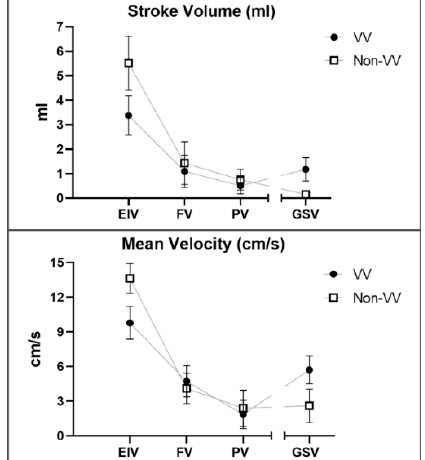
Figure 3. TRANCE-MRI hemodynamic parameters, consisting of stroke volume, forward flow volume, backward flow volume, regurgitant fraction, absolute volume, mean flux, stroke distance, and mean velocity, were analyzed in three valvular insufficiency cases and three venous occlusion cases. All patients with valvular insufficiency had paradoxically higher mean velocity and stroke volume in the GSV compared with the popliteal vein. EIV: external iliac vein; FV: femoral vein; PV: popliteal vein; GSV: greater saphenous vein; VV: venous valvular insufficiency; Non-VV: non venous valvular insufficiency.